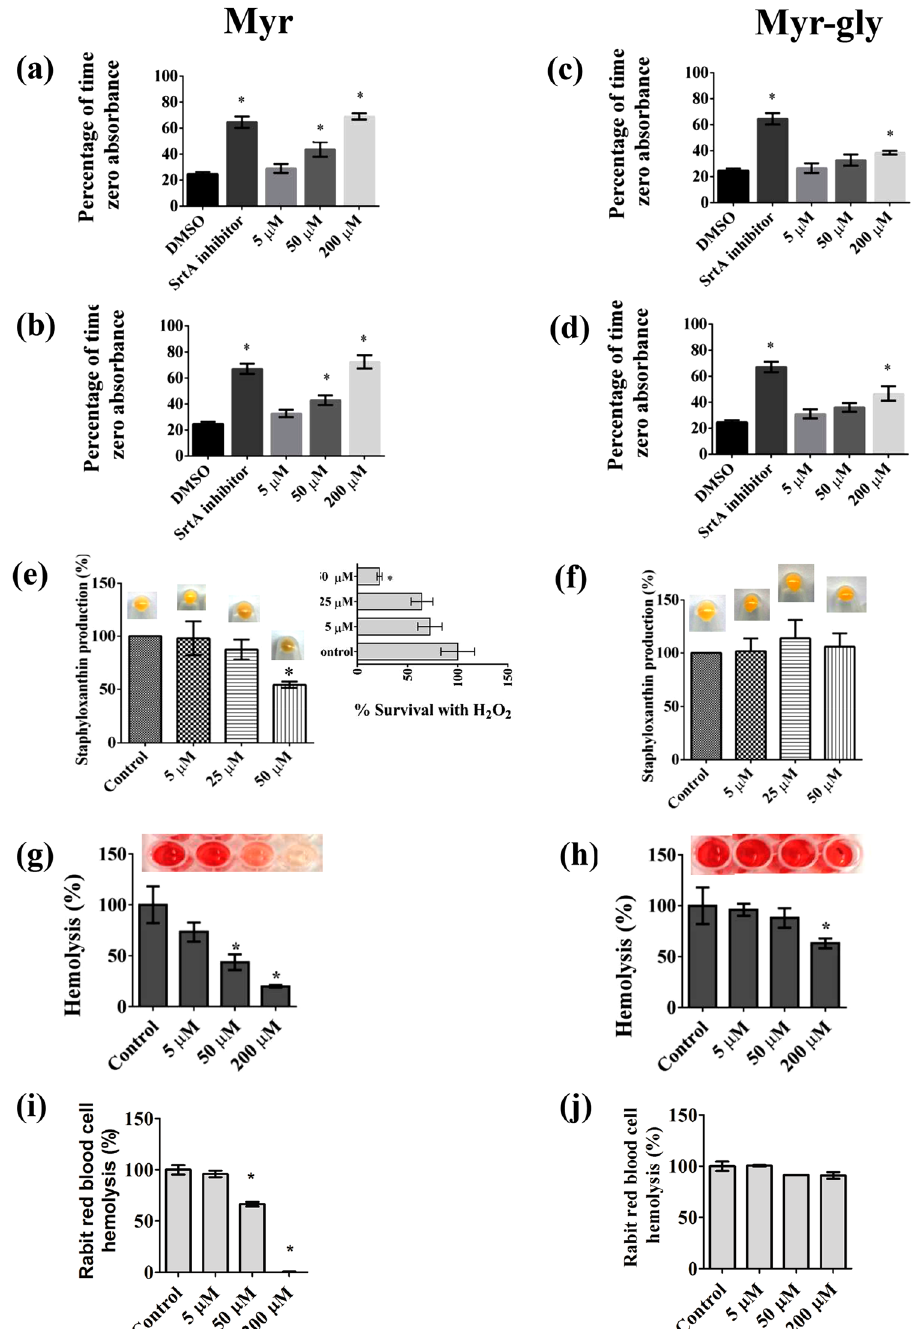
Figure 3. Effects of Myr and Myr-gly on S. aureus virulence factors: clumping, cell surface hydrophobicity, staphyloxanthin and hemolysis. ( a,b ) Inhibitory activity of Myr on the ability of S. aureus Newman and ATCC 6538 to clump with fibrinogen. ( c , d ) Inhibitory activity of Myr-gly on the ability of S. aureus Newman and ATCC 6538 to clump with fibrinogen. ( e ) Activity of Myr on the staphyloxanthin pigment production by S. aureus ATCC 6538. The insert present S. aureus ATCC 6538 susceptibility to H 2 O 2 after staphyloxanthin reduction induced by Myr. ( f ) Activity of Myr-gly on the staphyloxanthin pigment production by S. aureus ATCC 6538. ( g ) Hemolysis promoted by supernatants of Myr treated- S. aureus ATCC 29213. ( h ) Hemolysis promoted by supernatants of Myr-gly treated- S. aureus ATCC 29213. ( i ) Effect of Myr on purified Hla induced hemolysis. ( j ) Effect of Myr-gly on purified Hla induced hemolysis. * Represents statistically significant differences ( p -value < 0.01) in comparison to the control. The experiments were done in triplicate and representative images are